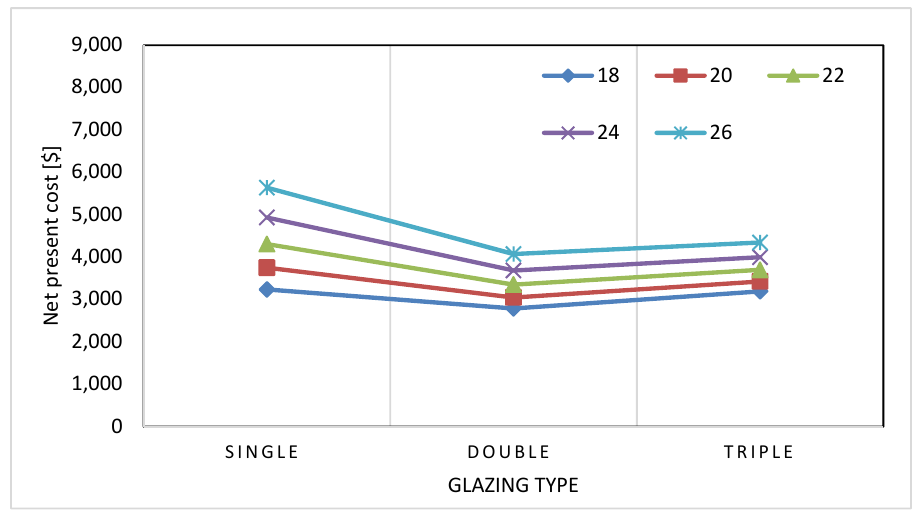
Figure 18. The influence of the heating set-point temperature on the net present cost for Istanbul.